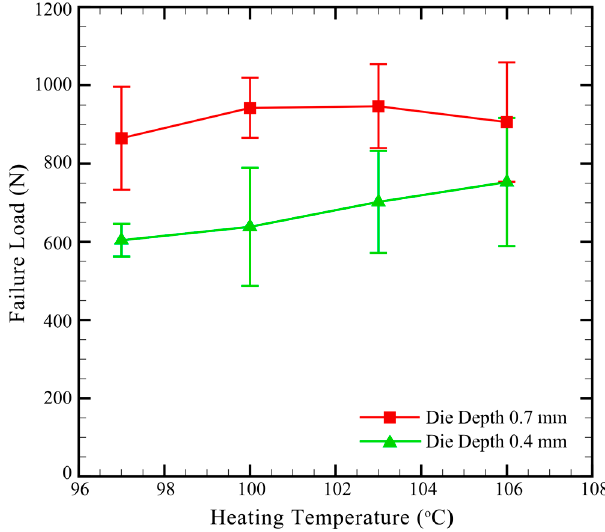
Figure 12. Failure load vs. heating temperature of clinch joints in CT specimens made by Die D1 ( d d : 0.7 mm) and Die D2 ( d d : 0.4 mm). The Punch P1, punching force of 69 kN, heating temperature 100 °C and Heating Mode B are used .